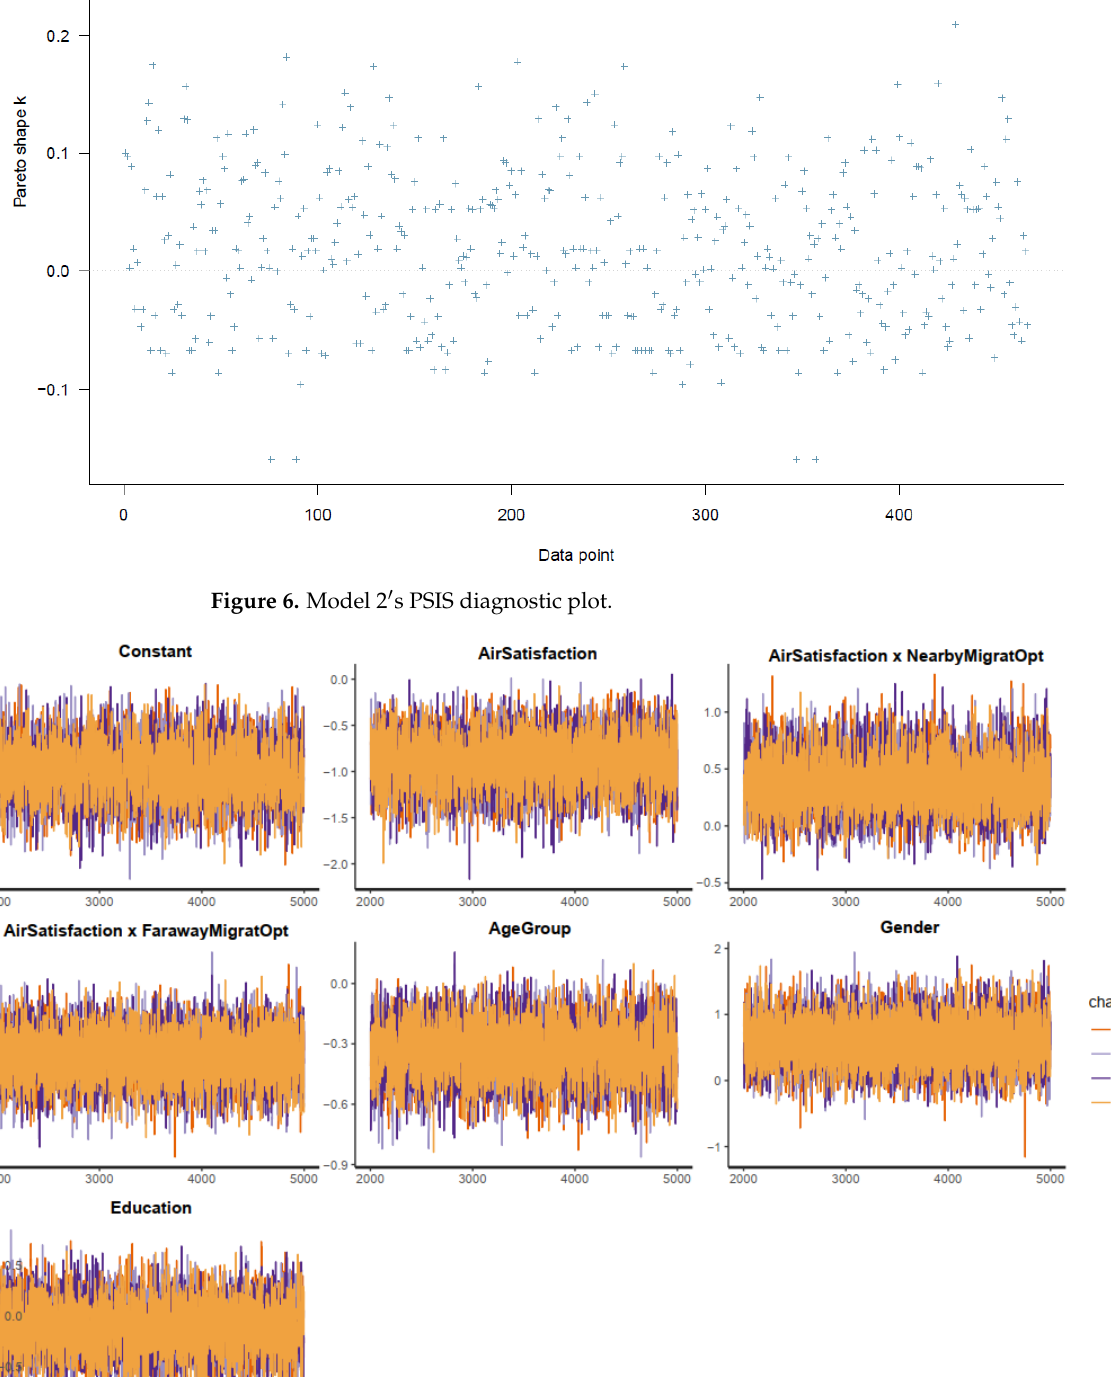
Figure 7. Trace plots for Model 2 ′ s posterior parameters. Table 3. Model 2 ′ s simulated posterior coefficients.